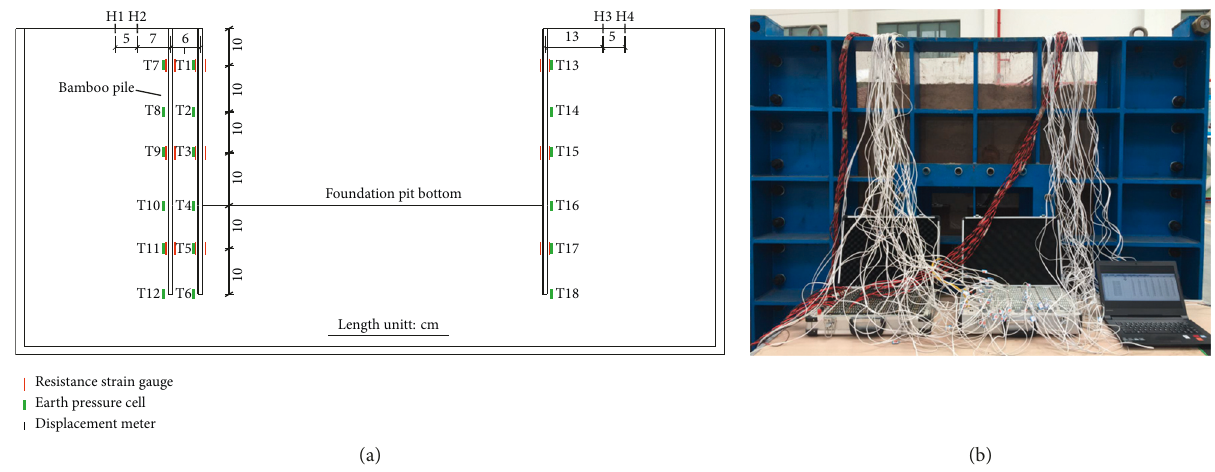
Figure 6: Measurement layout scheme and data acquisition. (a) Monitoring point arrangement. (b) Data